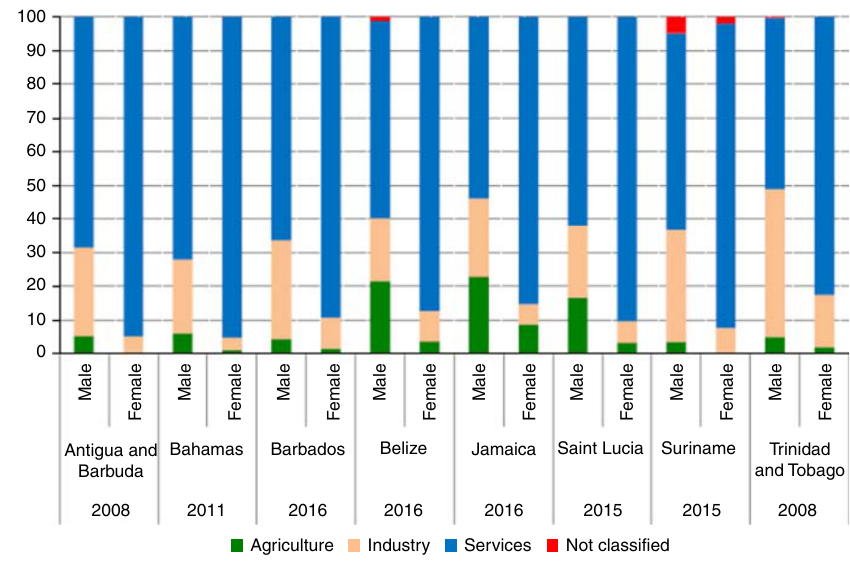
Figure 1. Distribution of employed labour force by industry groups and sex (Percentage and latest year